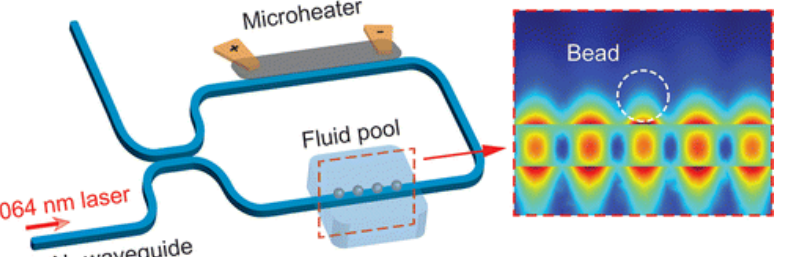
Figure 12. To the left is a schematic of the core components of a nSWAT device. To the right is a cross section of the electric field profile from a 3D full-wave electromagnetic simulation in the presence of a 349 nm polystyrene bead trapped at one of the antinodes of the standing-wave. Reprinted with permission from [85]. Copyright © 2016 American Chemical